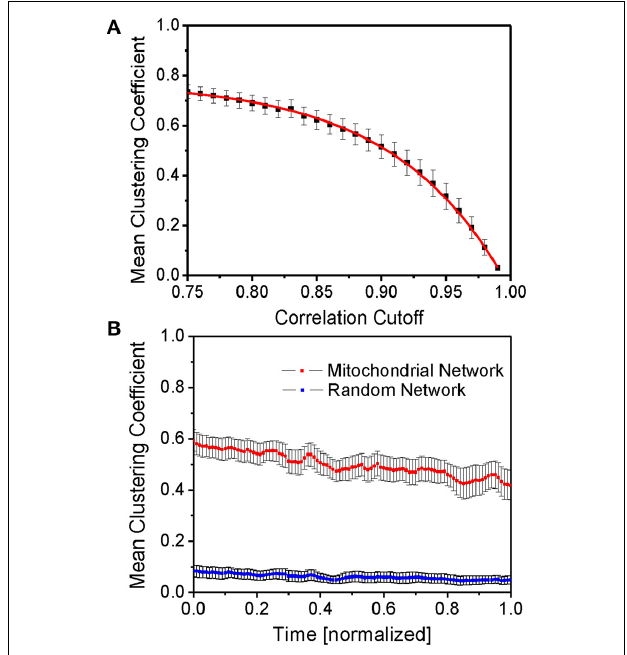
FIGURE 3 | Mean function clustering coefficient. (A) Time- and myocyte-averaged mean clustering coefficient for different cutoffs of the correlation coefficient as the defining threshold of functional connectedness. The red curve is an exponential fit curve of the form (cid:3) (cid:4) − t / b + c (for details and fit parameters see main text). (B) f ( t ) = a · Exp Time evolution of the mean clustering coefficient averaged over different myocytes ( N = 9) (red line) and for random networks on the same set of vertices and maximum degree (blue line). Evidently, the mitochondrial network, as opposed to the randomly constructed network, shows significant functional